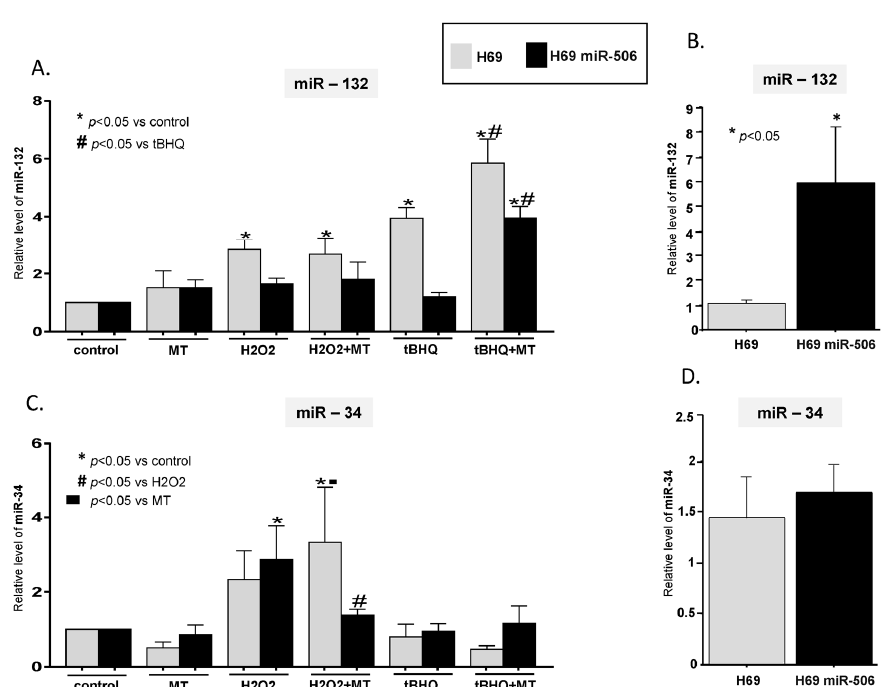
Figure 3. The e ff ect of melatonin on miR-132 and miR-34 expression in cholangiocytes under conditions of oxidative stress. ( A ) Oxidative stress induced either by H 2 O 2 or tert-Butylhydroquinone (tBHQ) enhanced the expression of miR-132 in H69 cells, whereas in H69miR-506 cells this response was only observed when the cells were treated simultaneously with tBHQ and melatonin. ( B ) The basal level of miR-132 expression was significantly increased in H69miR-506 cells in comparison to H69 cells. ( C ) H 2 O 2 induced miR-34 expression in both H69 and H69miR-506 cells. Melatonin suppressed this enhancement, but only in H69miR-506 cells. ( D ) The baseline expression of miR-34 was comparable in H69miR-506 and H69 cells. Each experiment was repeated four times with similar results. MicroRNA were analyzed using real-time PCR, and the results were normalized to miR-191. Values are shown as mean ± SE.